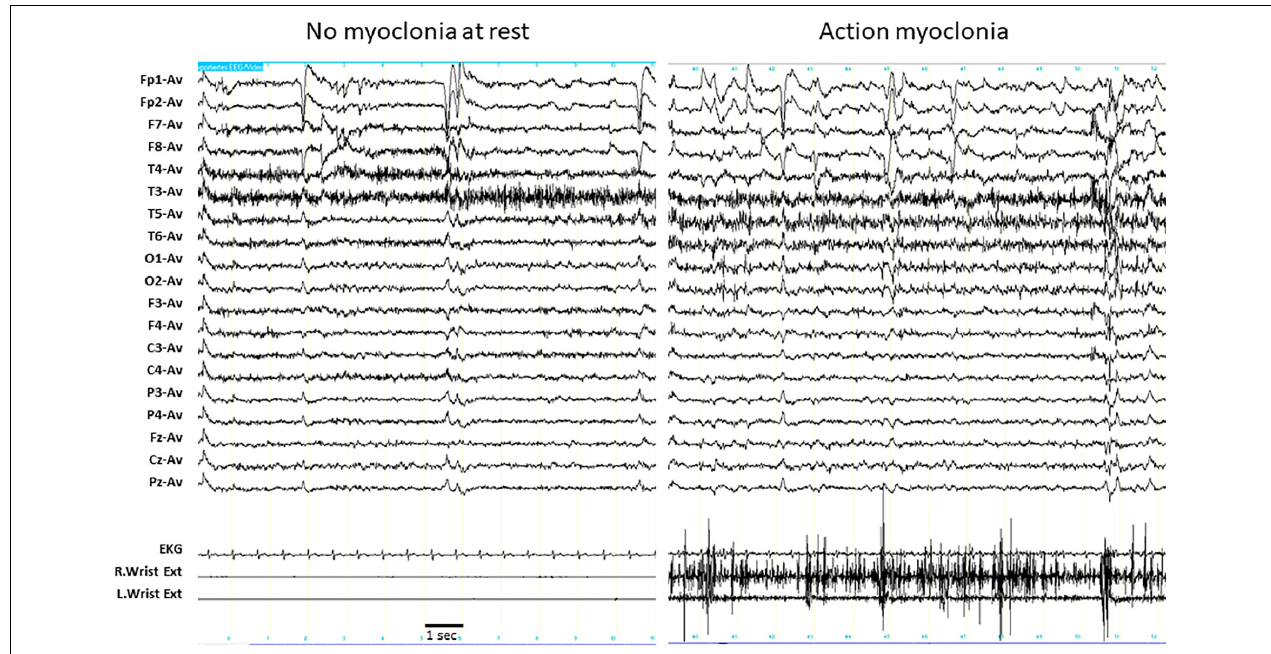
FIGURE 1 | EEG polygraphic recording in individual P3. Left panel: the individual is at rest. EEG does not show any epileptic abnormalities, and the myoclonic EMG activity is detectable in both wrist extensors. Right panel: the individual is maintaining a posture (outstretching her arms). The muscular contraction in both wrist extensors are fragmented by irregular, high amplitude, myoclonic potentials that are intermixed with brief silent periods, reproducing the EMG pattern of action myoclonus. No epileptic discharges associated with the myoclonic potentials were detectable in the EEG. Wrist Ext, wrist extensor; R, right; L, left.